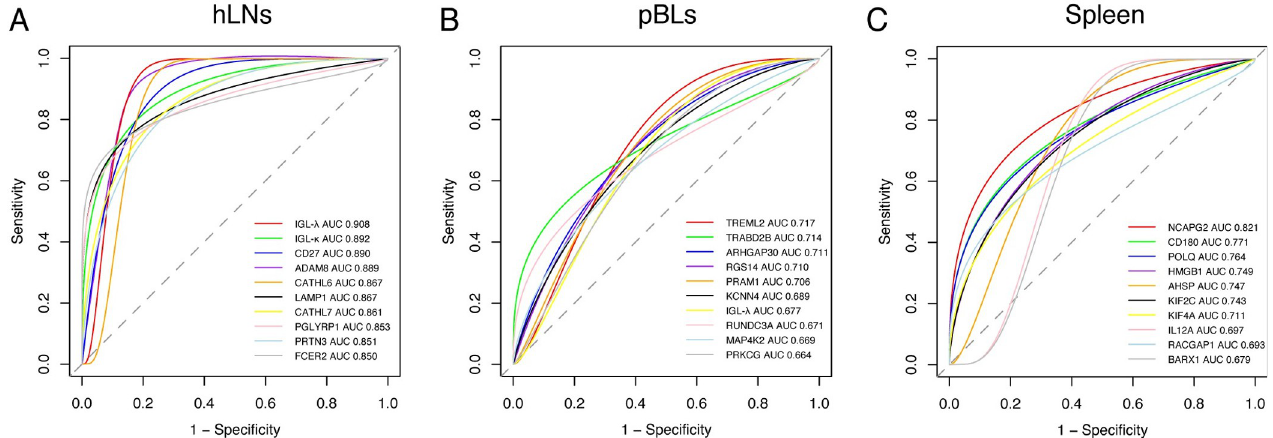
Fig 6. ROC curve analysis revealed hub genes associated with F . gigantica infection. The plot showing the top 10 hub genes with AUC value > 0.6 of hLNs (A), pBLs (B) and spleen (C).